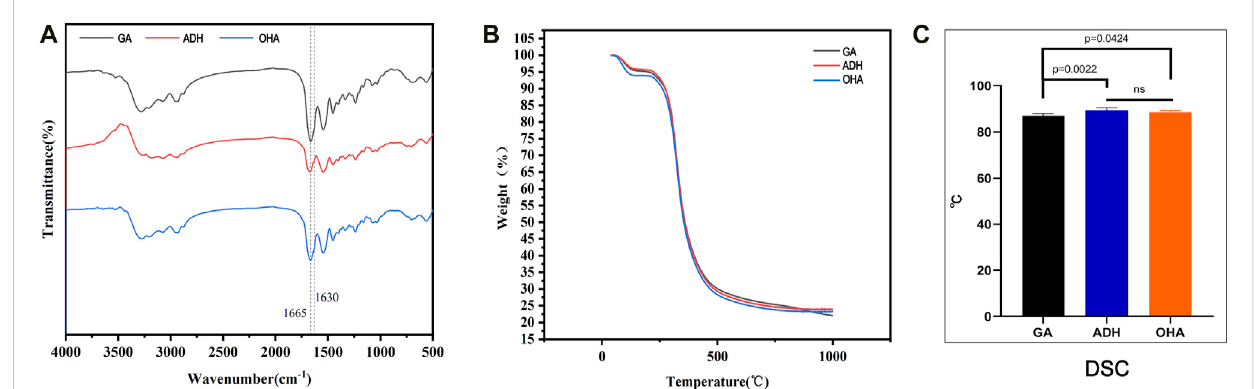
FIGURE 5 Results of FTIR spectra (A) and thermal analysis of the three groups of pericardium. Thermogravimetric analysis showed no signi fi cant differences among the three groups. (B) The thermal denaturation temperature of the ADH and OHA samples was distinctly improved compared to that of the GA samples (C)